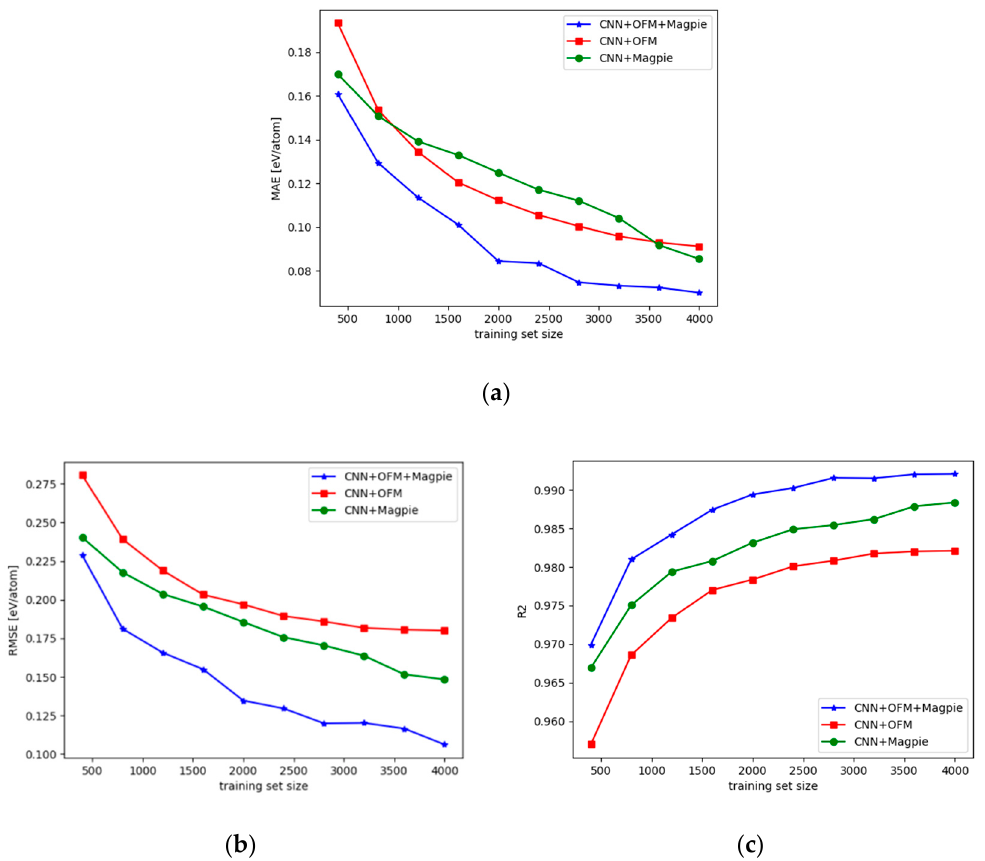
Figure 6. Prediction performance of multiple descriptor CNN when using OFM and Magpie descriptor. ( a ) MAE of different training set size. ( b ) RMSE of different training set size. ( c ) R 2 of different training set size.